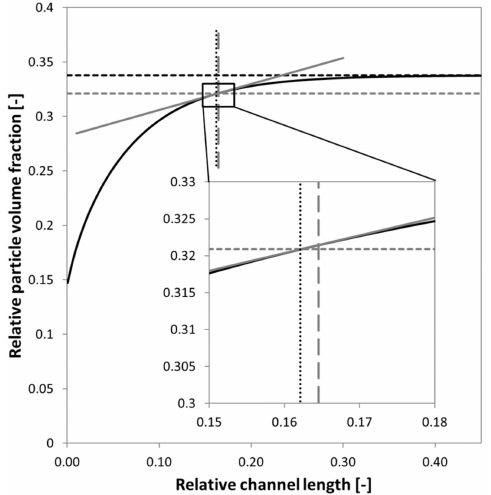
Figure A5. Schematic overview of how the entrance length is determined at the center of the channel and at 95% of the fully developed value. SID profile (black solid line); relative particle volume fraction for a fully developed profile (horizontal black dotted line); relative particle volume fraction at 95% (grey horizontal dotted line); tangent at 95% of the fully developed profile (grey solid